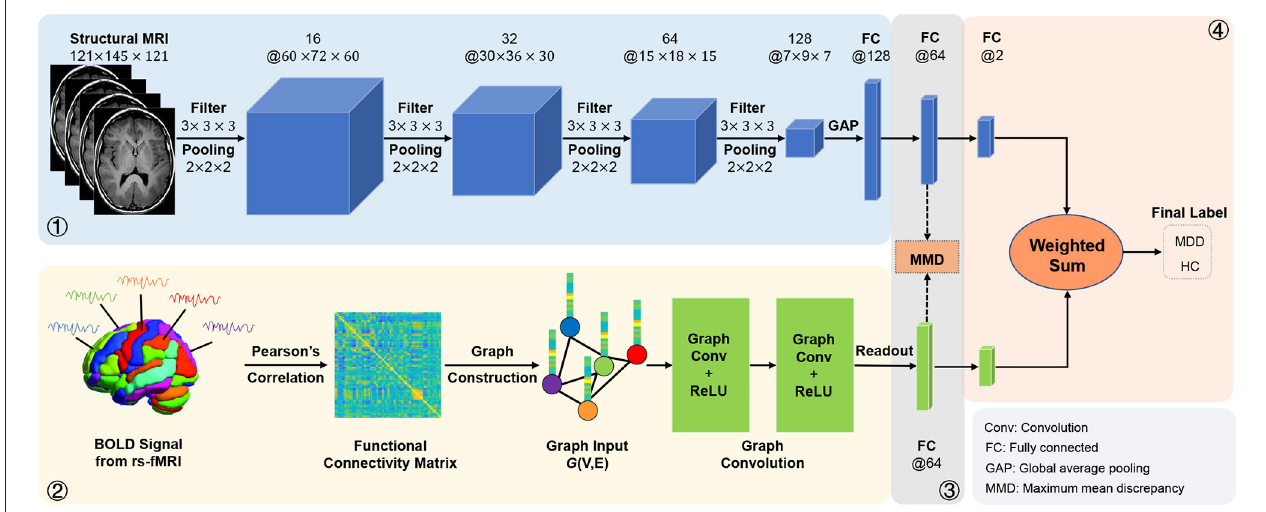
FIGURE 7 | Illustration of the adaptive multimodal neuroimage integration (AMNI) framework based on a decision-level fusion strategy.